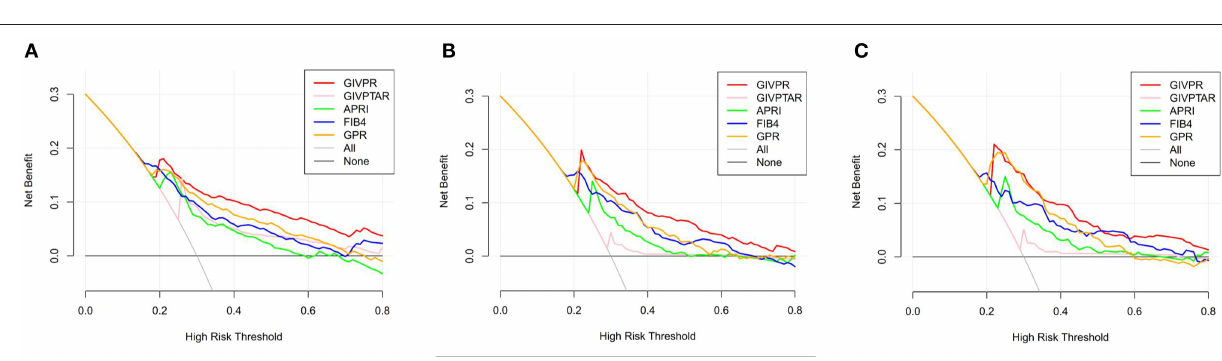
FIGURE 6 | Liver fibrosis decision curve analysis in validation set. Decision curve analysis depict the clinical net benefit. GIVPR is compared with GIVPTAR, APRI, FIB-4, and GPR for predicting significant fibrosis (A) ; GIVPR is compared with GIVPTAR, APRI, FIB-4, and GPR for predicting advanced fibrosis (B) ; GIVPR is compared with GIVPTAR, APRI, FIB-4, and GPR for predicting cirrhosis (C) . Black line, net benefit when no patient will experience the event; gray line, net benefit when all patients will experience the event. The preferred markers is the marker with the highest net benefit at any given